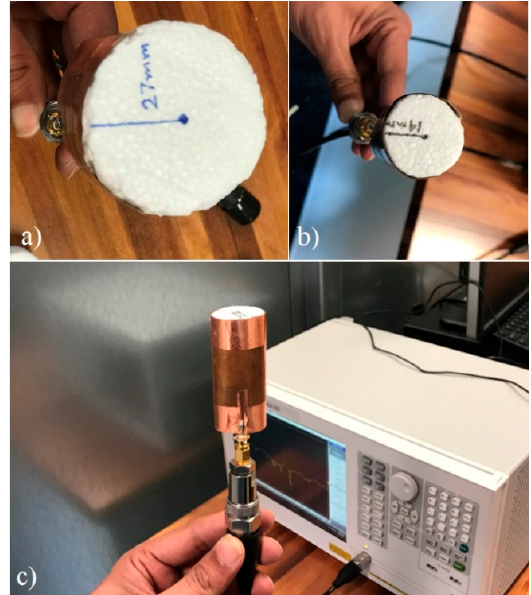
Figure 12. Cylindrical polystyrene foam to produce flexible antenna bend ( a ) at 27 mm, ( b ) at 14 mm, ( c ) connected to VNA at 14 mm.